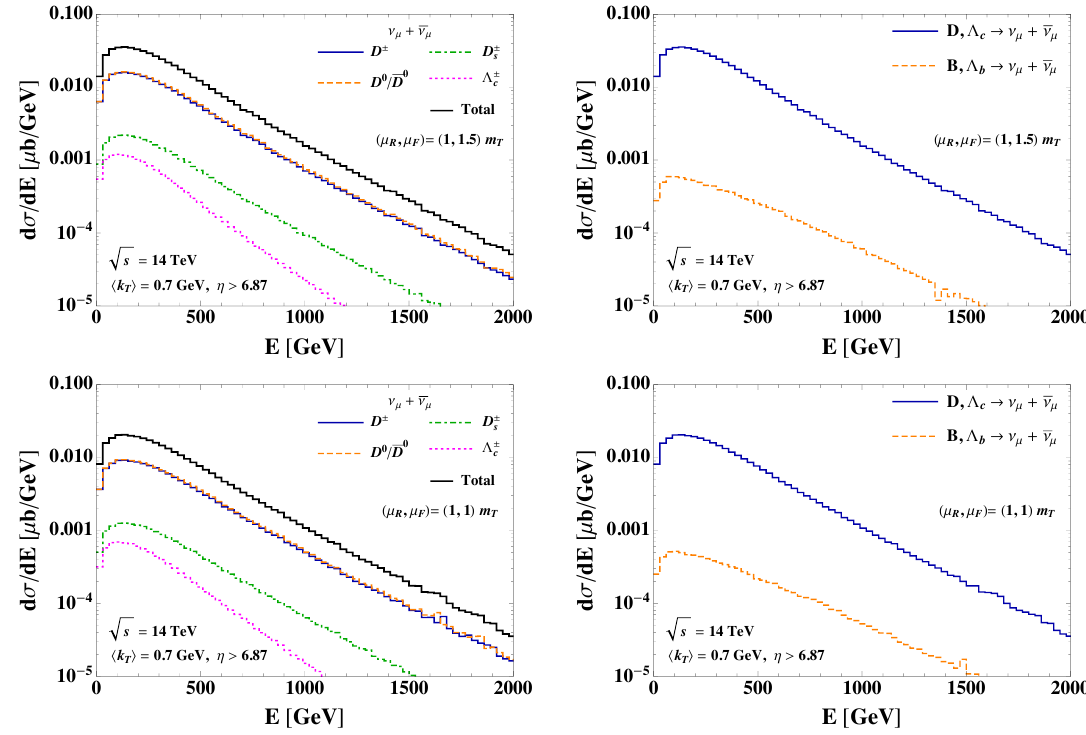
Figure 8 . Our predictions for the muon neutrinos plus antineutrinos energy distribution for pp p collisions at s = 14 TeV, with neutrino pseudorapidity (cid:17) > 6 : 87. Left: shown are the contributions from each charm hadron D + , D 0 , D + and (cid:3) c and their antiparticles, together with their sum. Right: s total contributions from the charm hadrons and bottom hadrons are presented, respectively. The total for B -hadrons accounts for the contributions from B + , B 0 , B + and (cid:3) b and their antiparticles. s The upper plots refer to the scale choice ( (cid:22) R ; (cid:22) F ) = (1 : 0 ; 1 : 5) m T , while the lower plots correspond to the conventional choice ( (cid:22) R ; (cid:22) F ) = (1 : 0 ; 1 : 0) m T . The value h k T i = 0 : 7 GeV is used as input in all